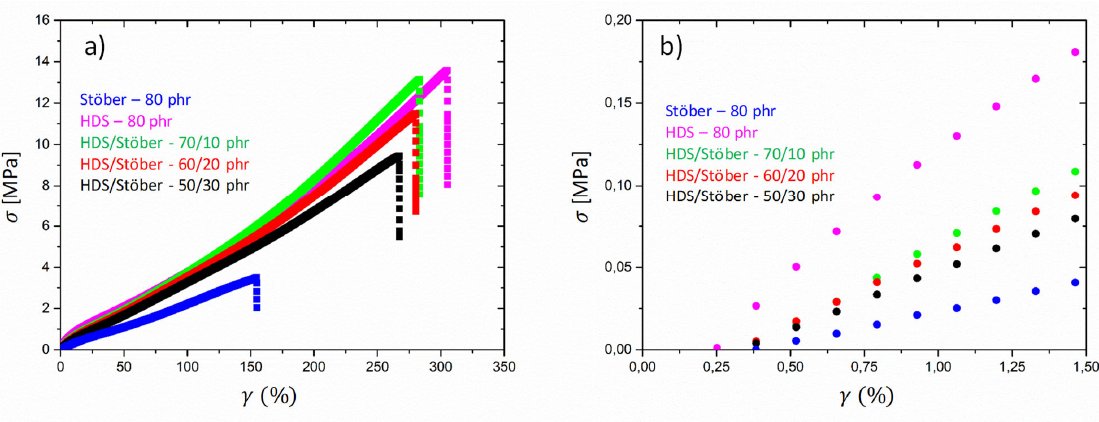
Figure 9. Stress-strain curves for mixtures of Stöber and HDS Silica dual filler compounds in the full deformation range ( a ) and at low deformation ( b ).